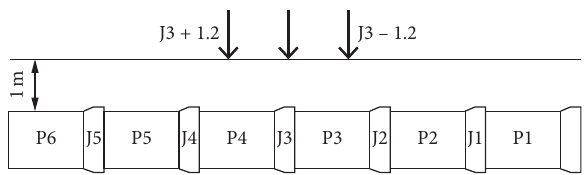
Figure 26: Definition of the load position.